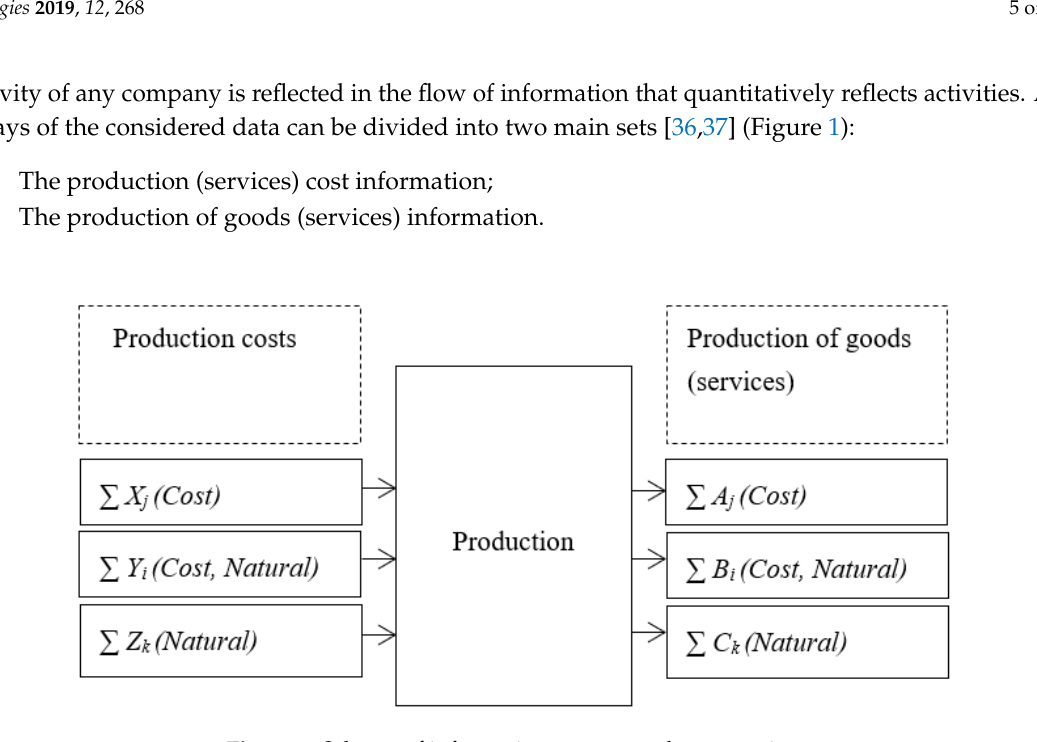
Figure 1. Scheme of information streams at the enterprise.